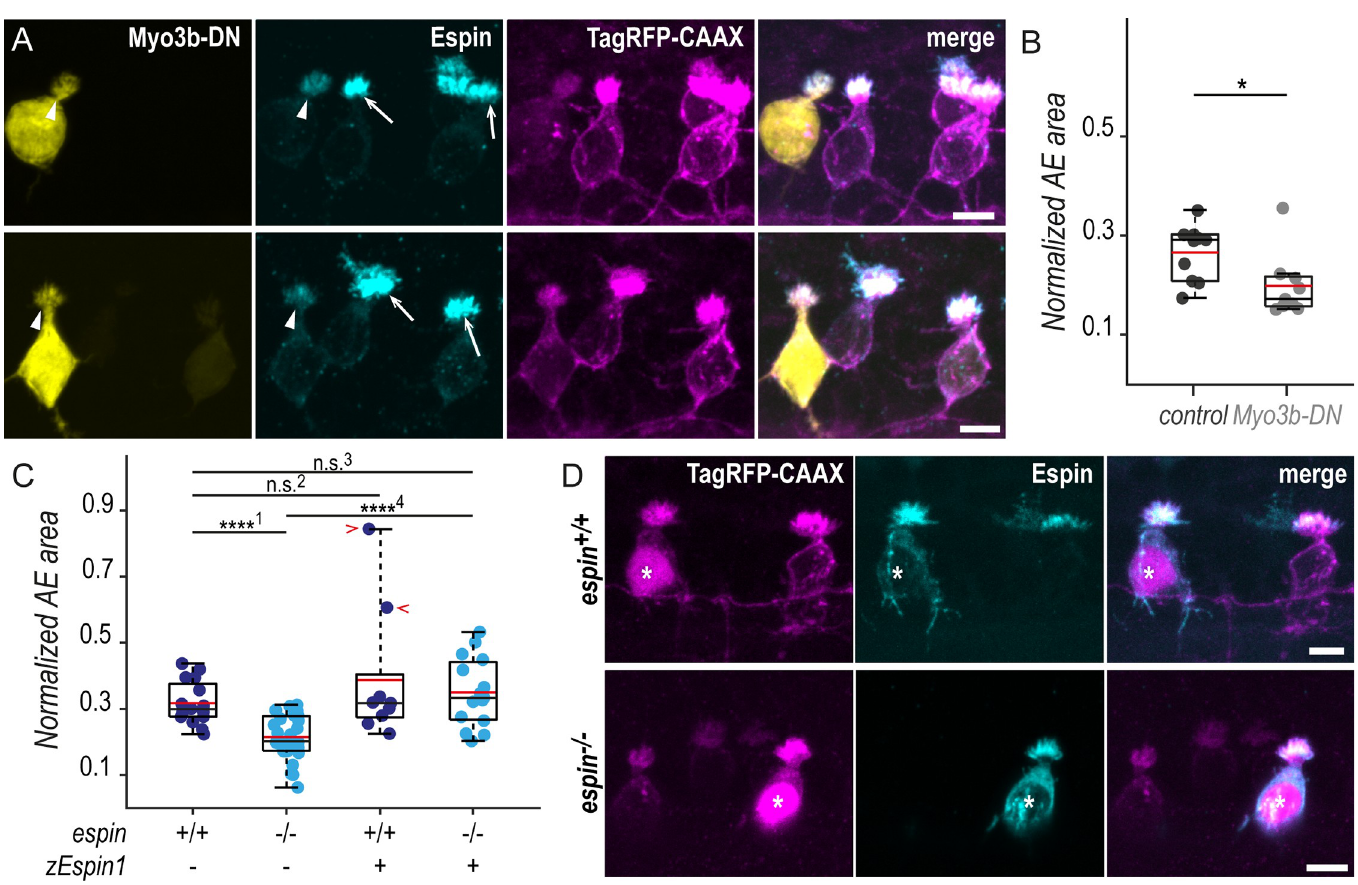
Fig 5. In the absence of Espin actin-bundling activity, CSF-cNs form shorter apical extensions. (A) Z-projections of whole-mounted spinal cords at 72 hpf showing mosaic expression of Myo3b-DN under the control of the pkd2l1 promoter. Immunostaining reveals Espin (cyan) in TagRFP-CAAX-positive CSF-cNs (magenta) expressing Myo3b-DN (yellow, arrowheads) or not (arrows). In ventral CSF-cNs expressing Myo3b-DN, Espin staining is reduced (observed in 9 cells out of 9), and the AE appears smaller compared with wild-type cells. (B) Quantification of the normalized area covered by the AE of ventral cells expressing Myo3b-DN ( N = 9 cells) compared with nonexpressing neighboring cells (control ; N = 10 cells). Cells expressing Myo3b-DN form a significantly smaller AE ( N = 5 fish; p = 0.025). (C) The same quantification was performed in espin −/− ventral cells at 72 hpf ( N = 30 cells in 5 fish) compared with wild-type cells ( N = 16 cells in 5 fish). Mutant cells display significantly smaller AEs ( p 1 = 8.4010 × 10 − 6 ). In wild-type ventral cells, the overexpression of the zEspin1 was sometimes associated with abnormally long microvilli (observed in 2 cells out of 9; red chevrons; p 2 = 0.2123). In espin −/ − cells, the mutant phenotype was rescued by zEspin1 ( N = 15 cells; p 3 = 0.3029 and p 4 = 3.8556 × 10 − 6 ). (D) Z-projections of whole-mounted spinal cords at 72 hpf showing mosaic expression of zEspin1 under the control of the pkd2l1 promoter. Immunostaining for Espin (cyan) in TagRFP-CAAX-positive ventral CSF-cNs (magenta) reveals the loss of Espin immunoreactivity in espin −/− larvae, which is retrieved in mutant cells expressing zEspin1 (nuclear RFP; magenta; stars). Scale bars, 5 μ m. Underlying data can be found in S1 Data. AE, apical extension; CSF-cN, cerebrospinal fluid-contacting neuron; DN, dominant-negative; hpf, hours post fertilization; Myo3b, myosin 3b;n.s., not significant; RFP, red fluorescent protein; zEspin1, zebrafish Espin isoform 1.